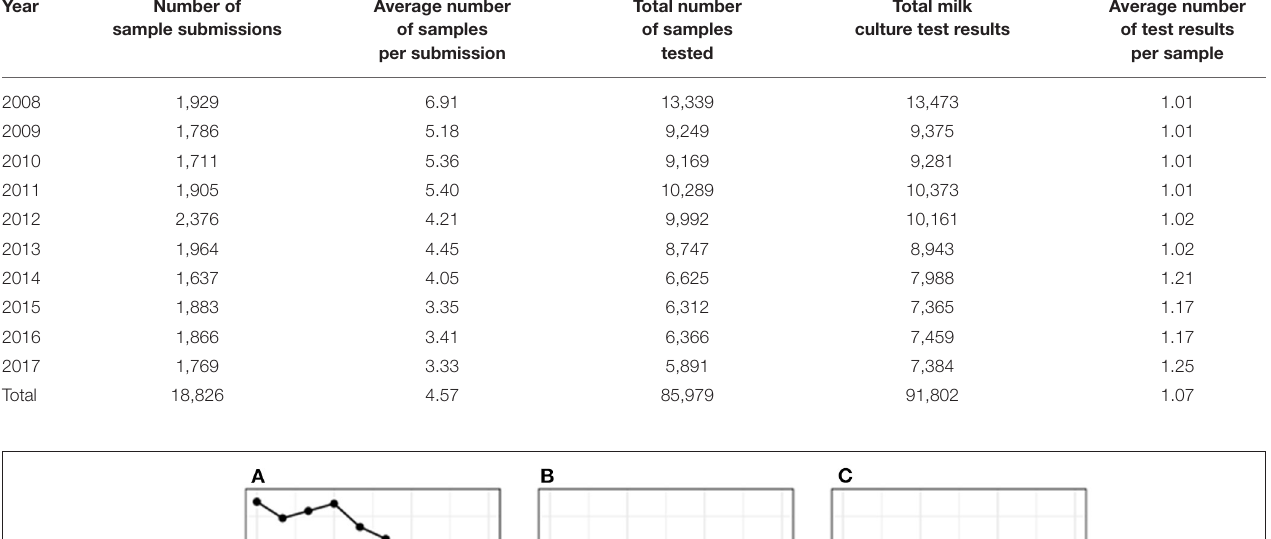
TABLE 1 | The final data included a total of 85,979 milk samples that were cultured between 2008 and 2017 in the Animal Health Laboratory, Ontario, Canada. Year